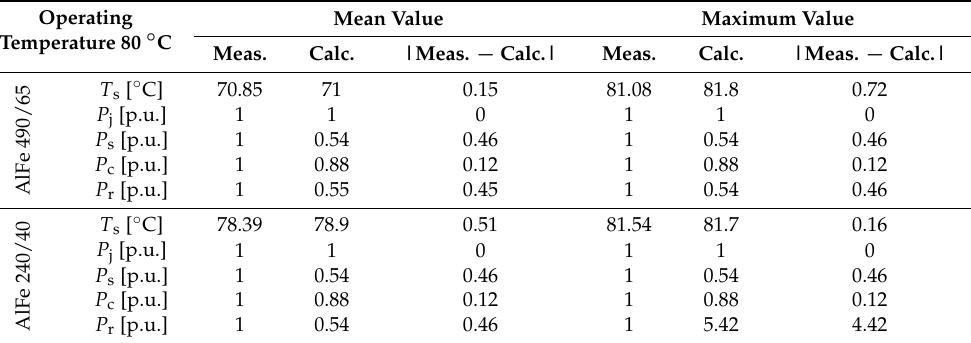
Table 3. Measured (meas.) and model-calculated (calc.) mean and maximum values of the conductor temperature, heating and cooling powers (per unit values) for the conductor AlFe 490/65 and AlFe 240/40 at operating temperature 80 ◦